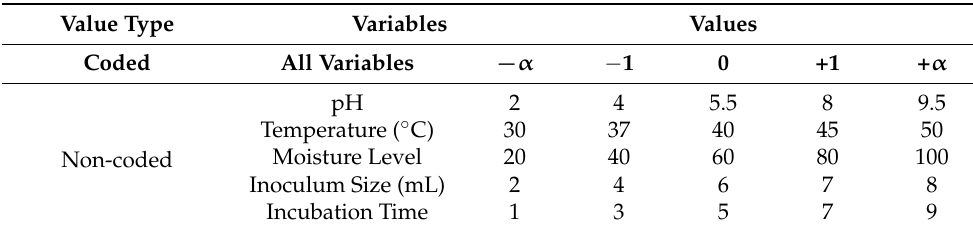
Table 1. Coded and Non-Coded Values. Value Type